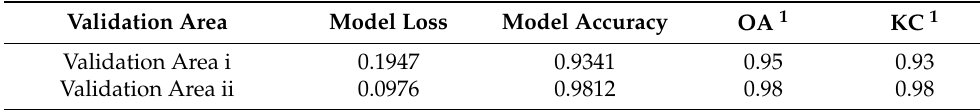
Figure 12. Validation area classification. ( a ) Validation Area i true color image (Red, Green, Blue) display; ( b ) Classification results of Validation Area i; ( c ) Validation Area ii true color image (Red, Green, Blue) display; ( d ) Classification results of Validation Area ii. Table 5. Validation Area Model and Classification